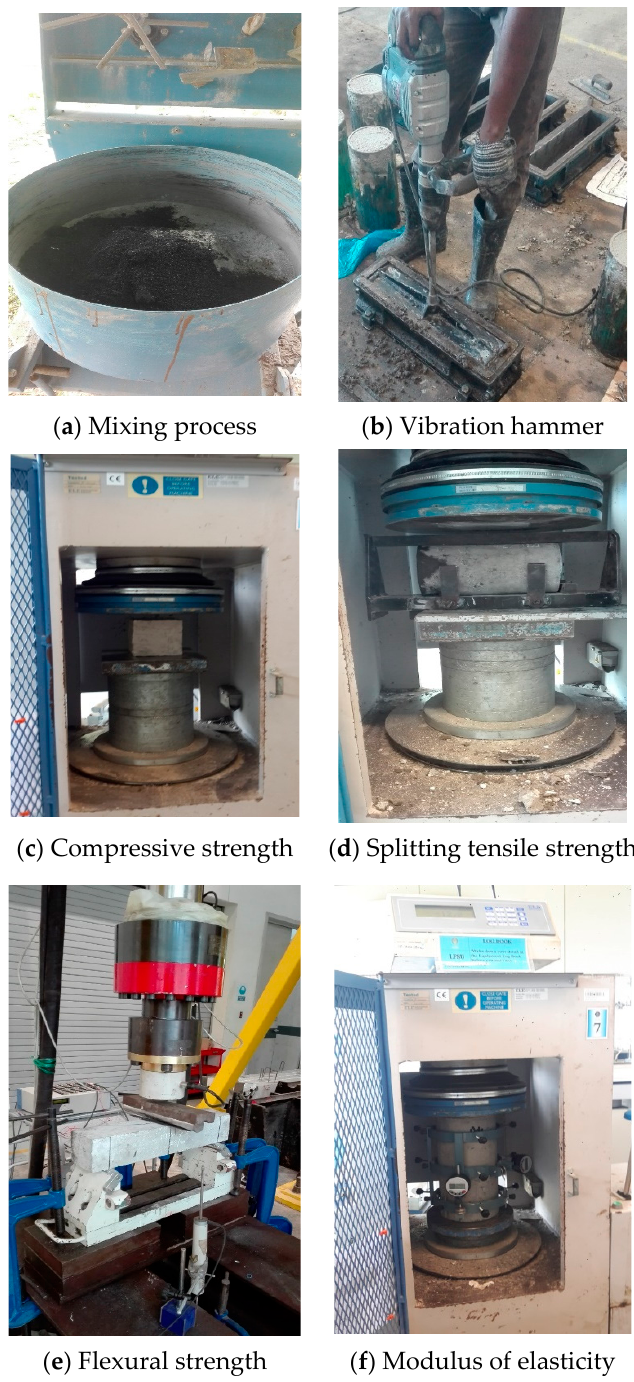
Figure 3. Experimental setup.